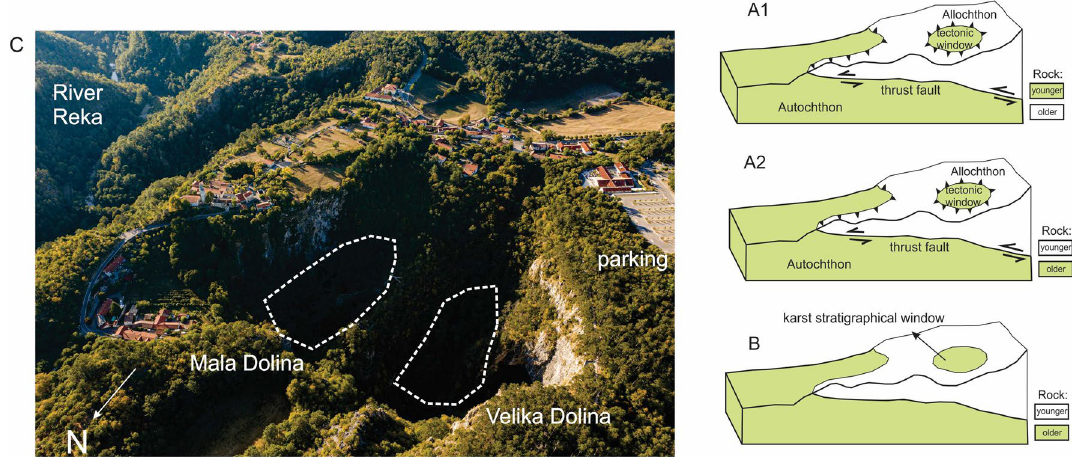
Fig. 6 Schematic picture of: A. tectonic window ( A1 —older rocks thrusted over younger rocks, A2 —younger rocks thrusted over older rocks); B karst stratigraphical window; C the area around Mala Dolina and Velika Dolina (Photo Matej Blatnik)